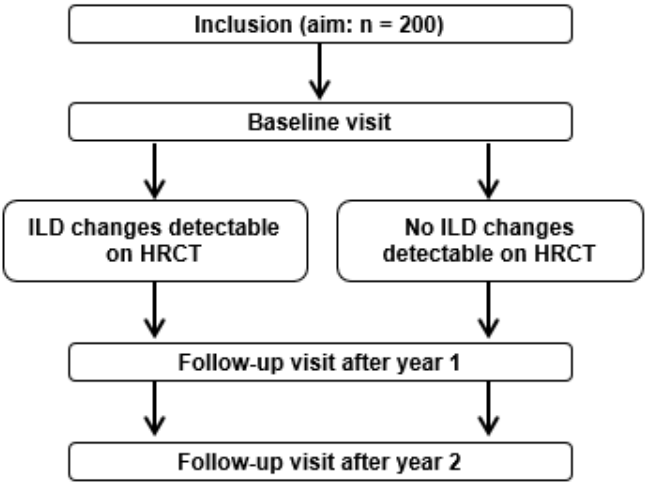
Figure 1. Study groups of the FLORIS study. Definition of abbreviations: ILD = interstitial lung disease and HRCT = high-resolution computed tomography. Table 1. Study schedule of the FLORIS study .